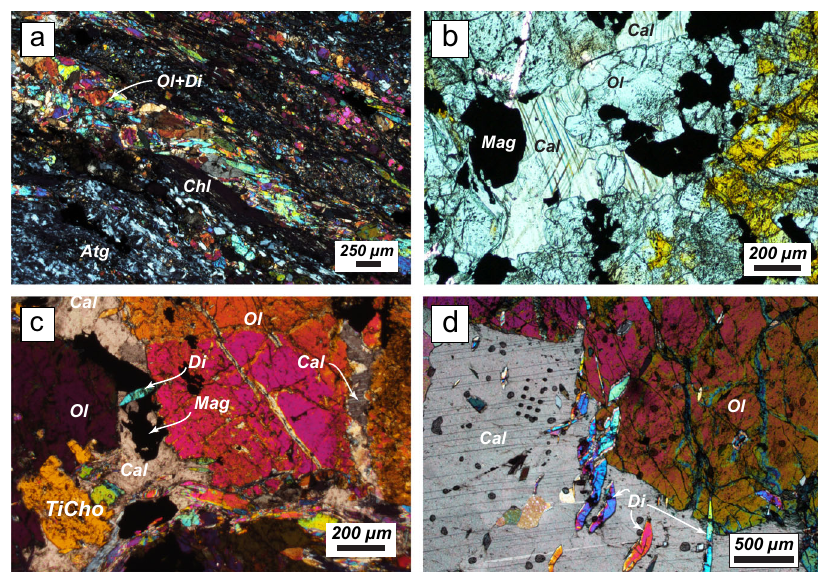
Fig. 3 Vein thin sections pictures. a Plane polarized view of the veins observed in Fig. 2a showing a Ol ± Di ± Chl vein crosscutting the Atg bearing serpentinite. b Interstitial calcite, olivine, and magnetite in sample ZE17-21, also showing olivine replacing Ti-clinohumite (orange mineral on the right side). c Sample ZE17-05, with interstitial calcite, magnetite, and diopside that overprint olivine replacing TiCho. d Sample Trock16-12 showing the relationships between olivine and calcite, and the overprint by minute